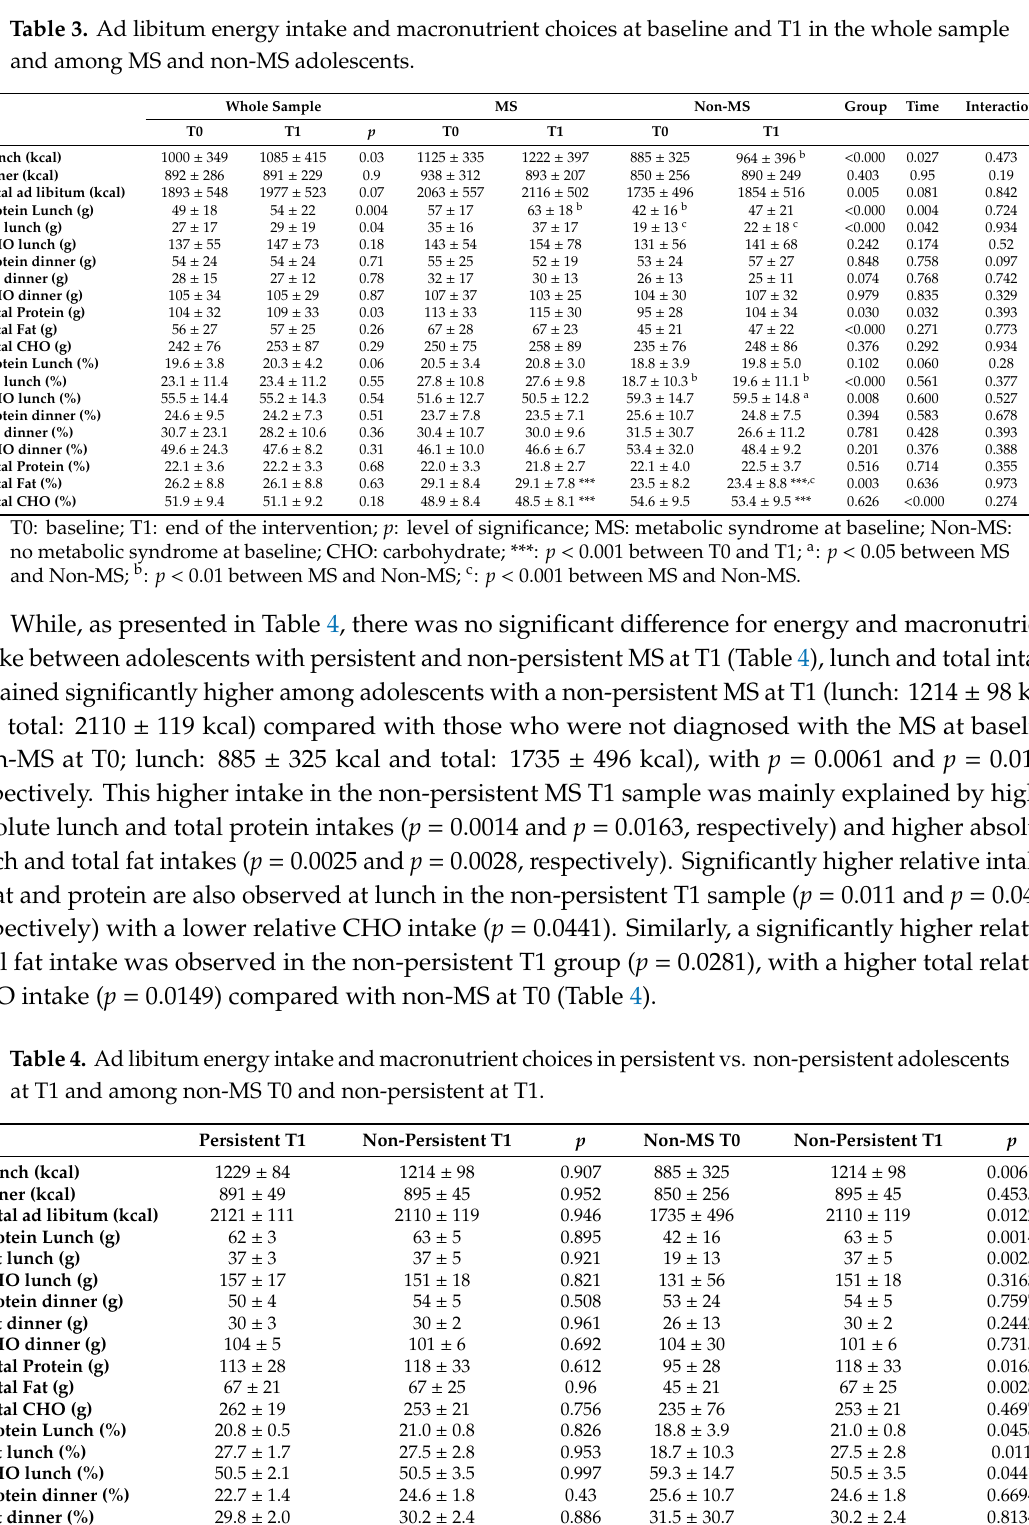
Table 3. Ad libitum energy intake and macronutrient choices at baseline and T1 in the whole sample and among MS and non-MS adolescents.